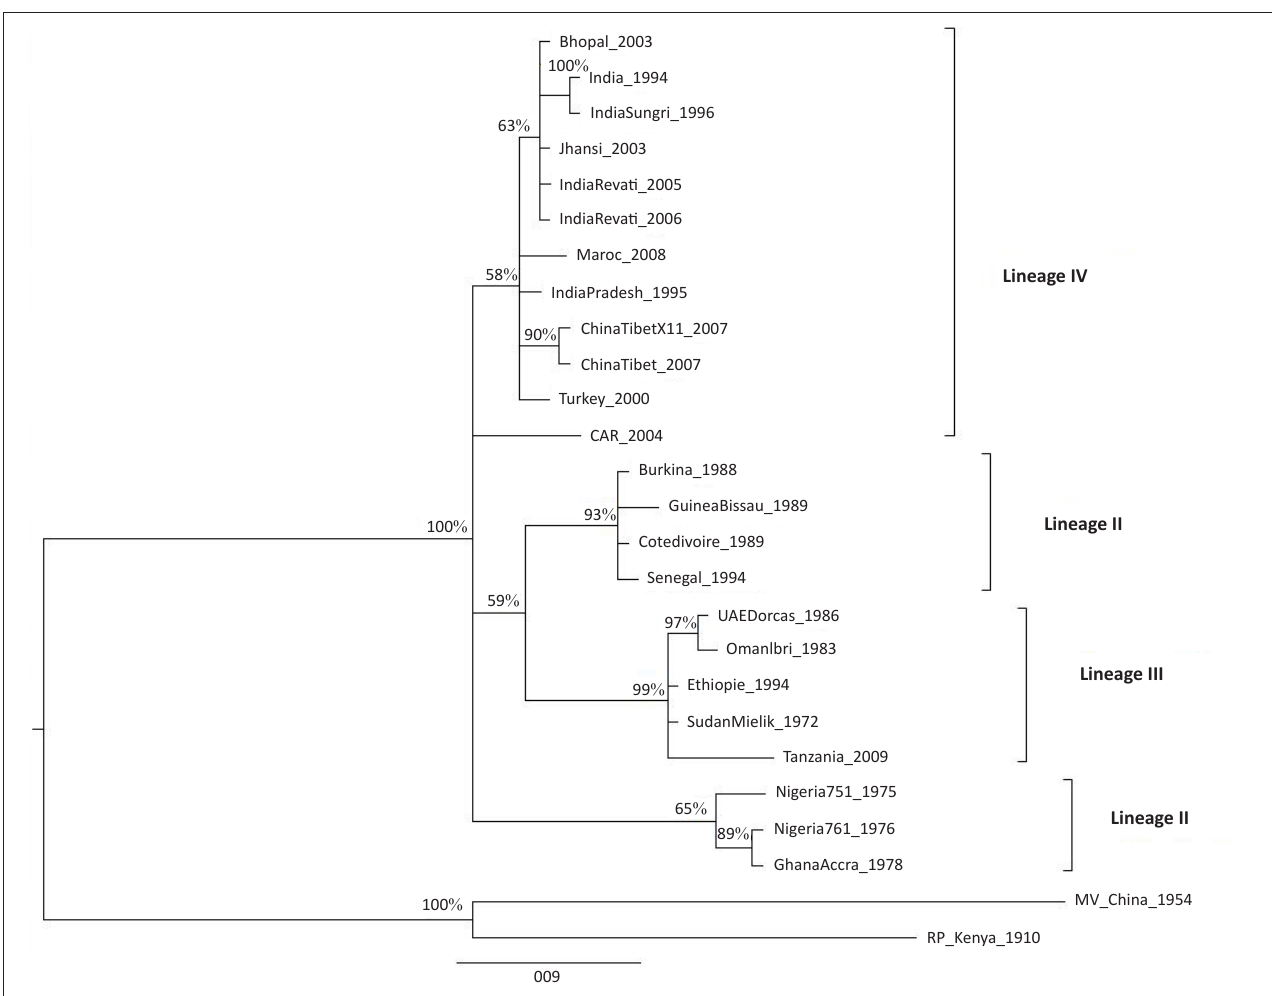
FIGURE 2: Phylogenetic tree based on the nucleoprotein gene of the peste des petits ruminants virus, positioning the Tanzania strain in lineage